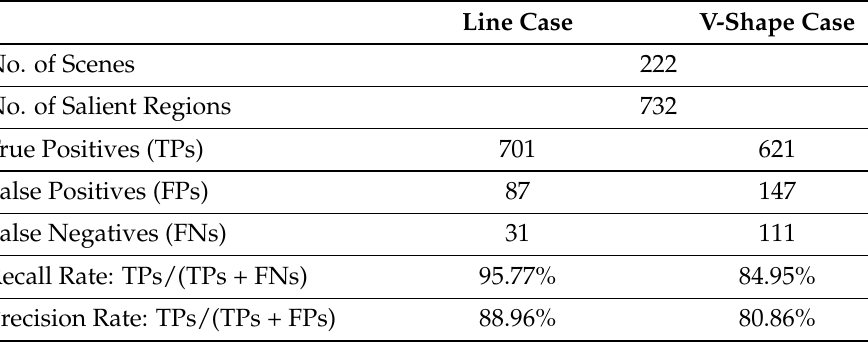
Table 1. Statistical